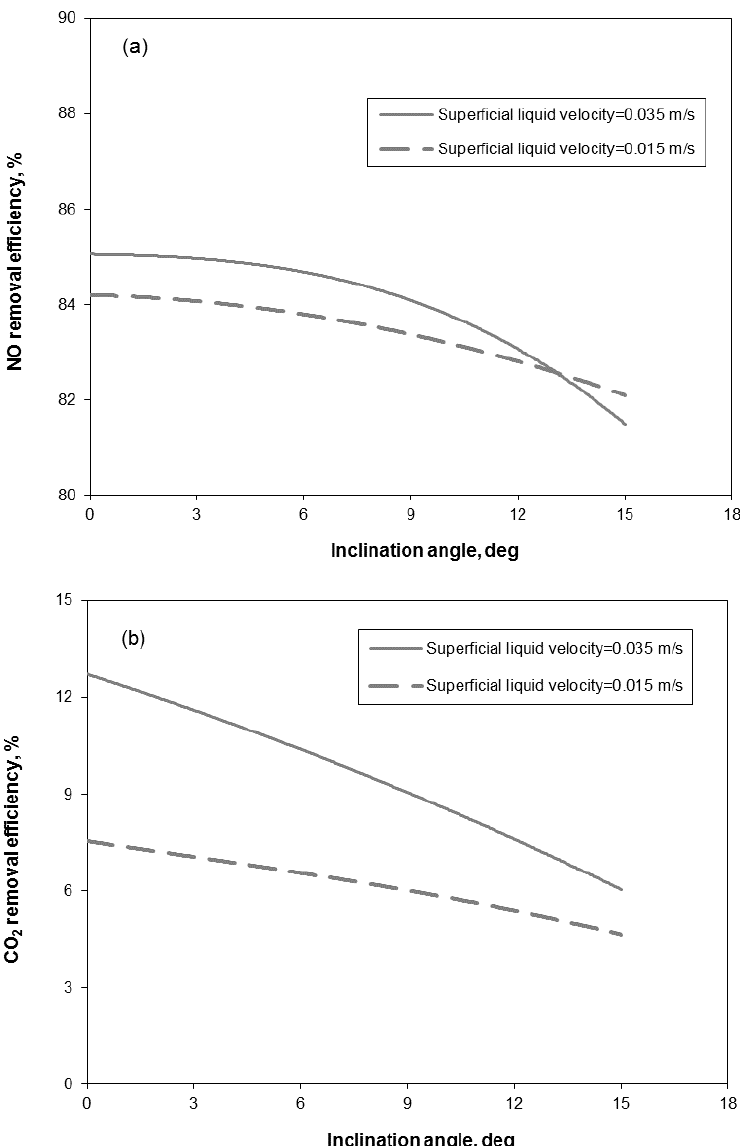
Figure 15. NO ( a ) and CO 2 ( b ) removal efficiency vs. seawater scrubber inclination angle at different values of liquid velocity (Packed-bed column with Raschig super-Rings; H = 5 m; Pressure = 2.5 MPa).